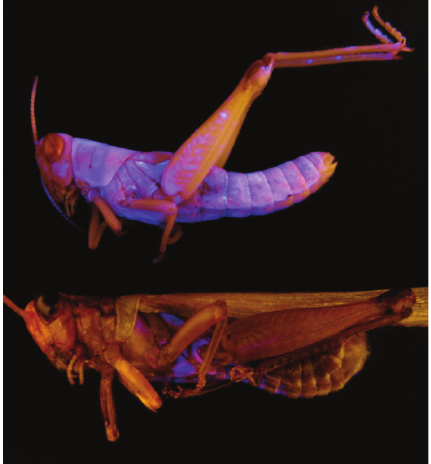
Figure 1: Blue fluorescence in UV light on a nymph (top) and adult male (bottom) Melanoplus herbaceus (Orthoptera: Acrididae). Photos not to scale. Color intensity digitally increased.